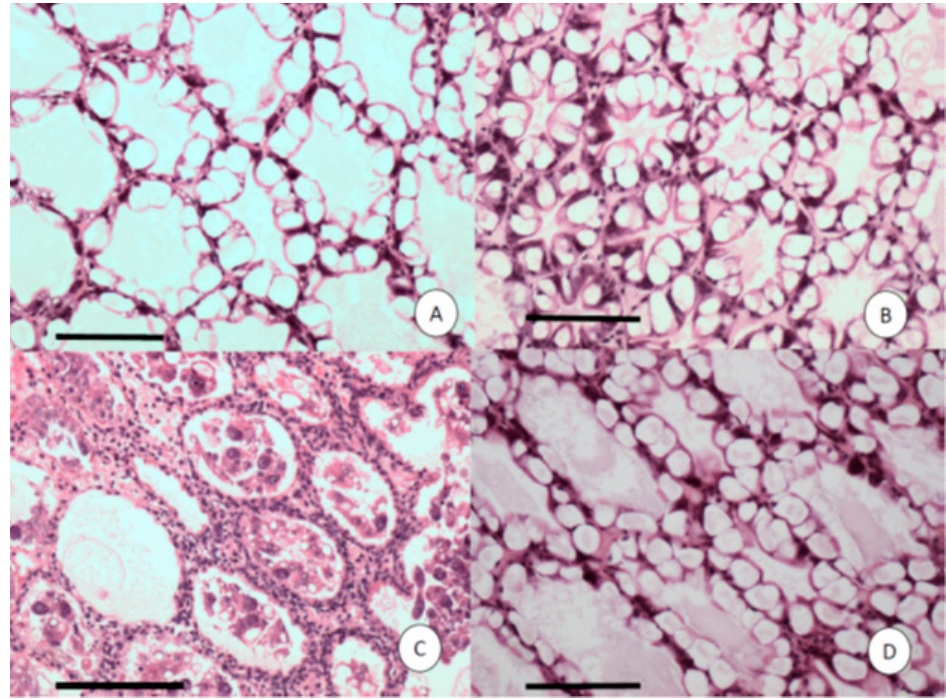
Figure 4. Histological sections of the hepatopancreas (HP) of Penaeus vannamei shrimp challenged with four strains of Vibrio parahaemolyticus . ( A ) V.P-ATCC; ( B ) R13; ( C ) VP AHPND strain A3; ( D ) R14 isolate. Only C displays acute HP necrosis with severe sloughing of HP tubule epithelial cells. Mayer–Bennett H&E. Scale bars = 100 μ m.